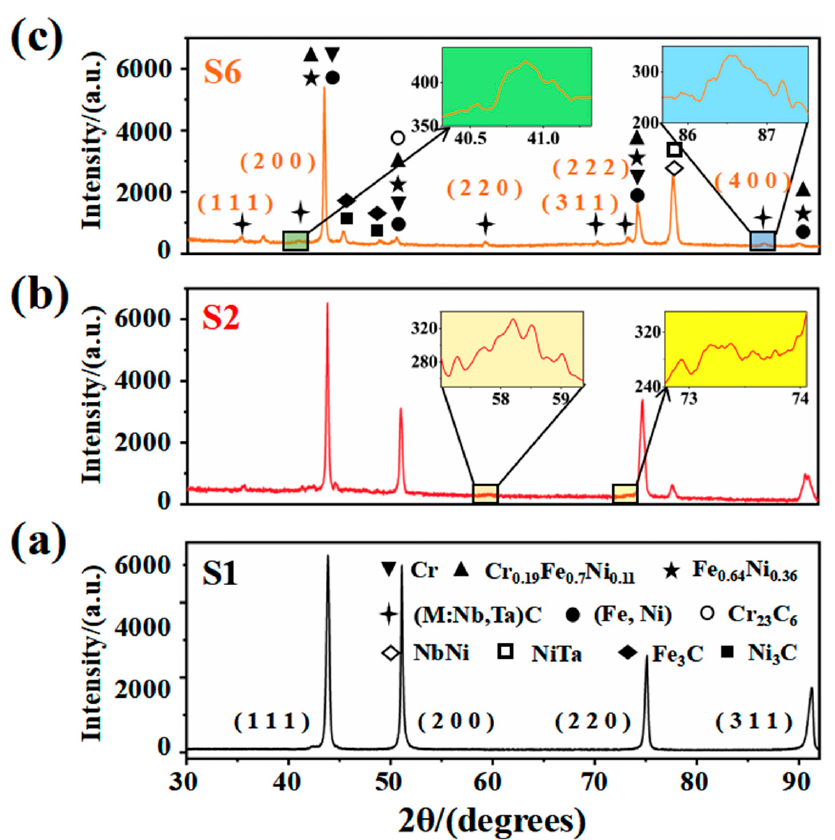
Figure 1. XRD results of composite coating with different ceramic micro-particle content ( a ) S1; ( b ) S2; ( c ) S6.